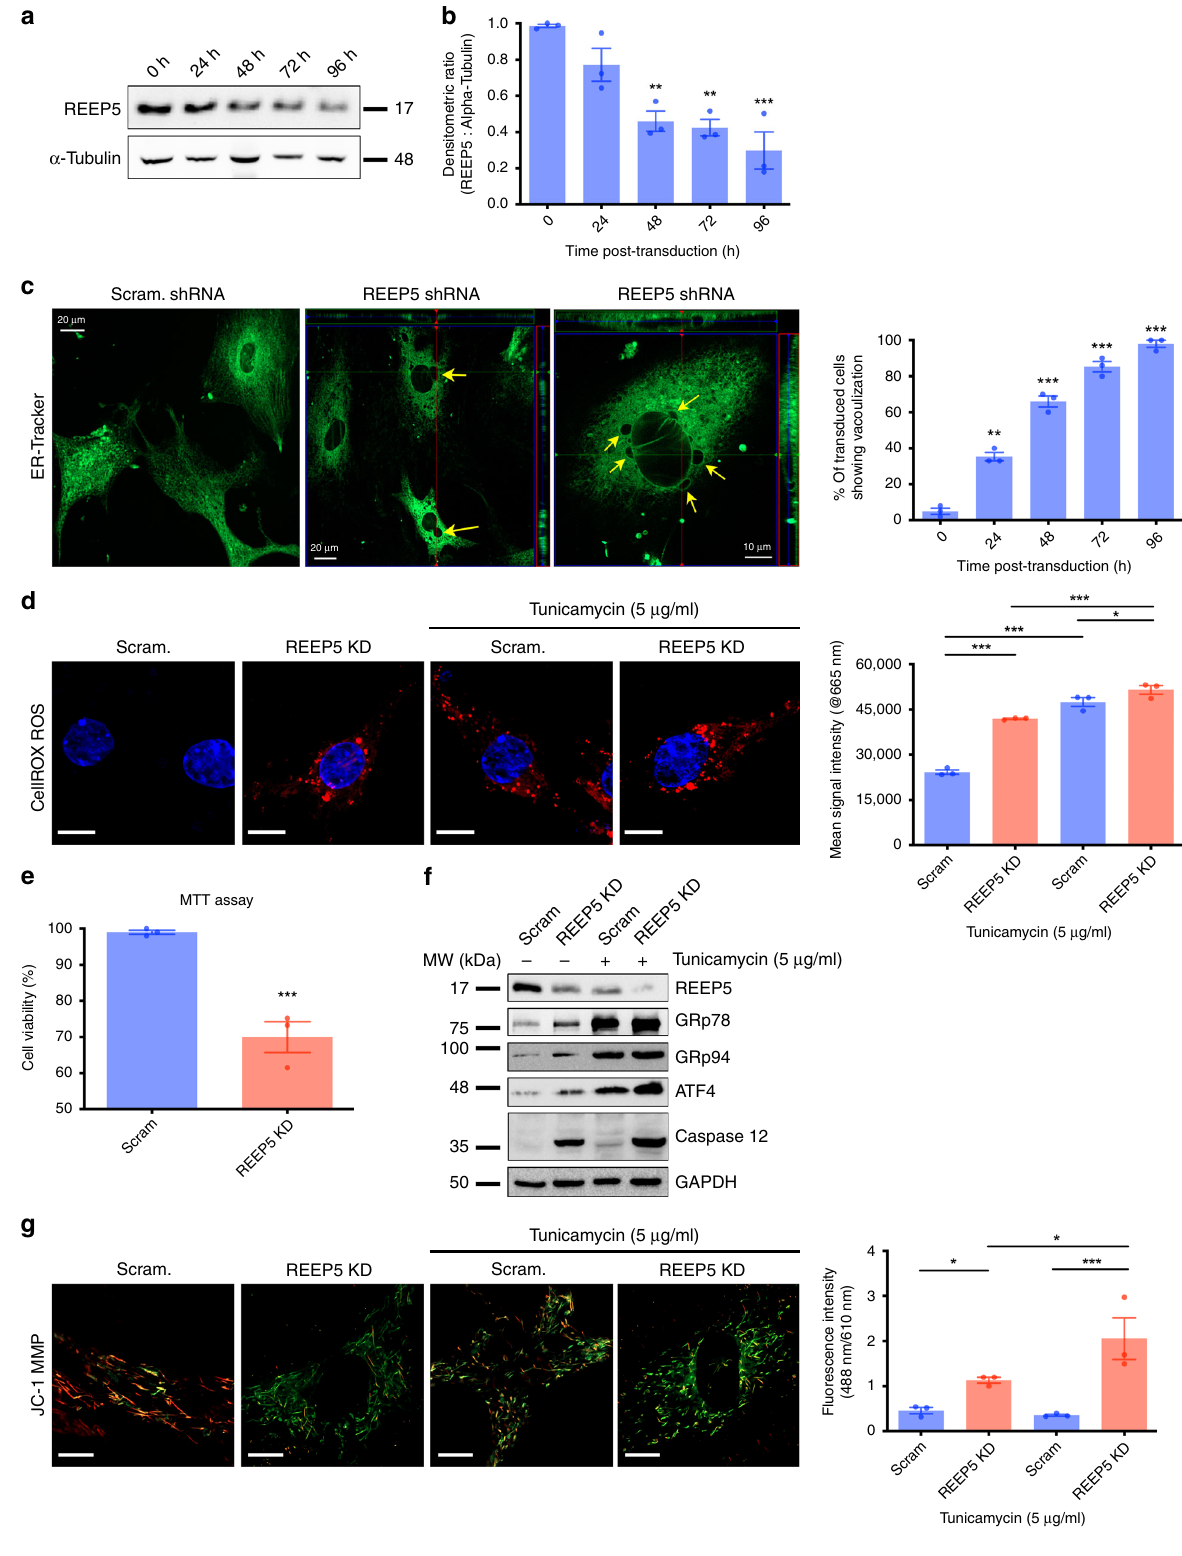
REEP5 depleted myocytes (Fig. 4e). A signi fi cant decrease in the number of spontaneous Ca 2 + transients (1.07 ± 0.05% in scram vs. 0.47 ± 0.03% in REEP5 KD; p = 0.0006) and an increased peak amplitude (25 ± 1.5% in scram controls vs. 58.6 ± 1.8% in REEP5 KD; p = 0.0002) of these transients were observed in REEP5 depleted myocytes (Fig. 4e,